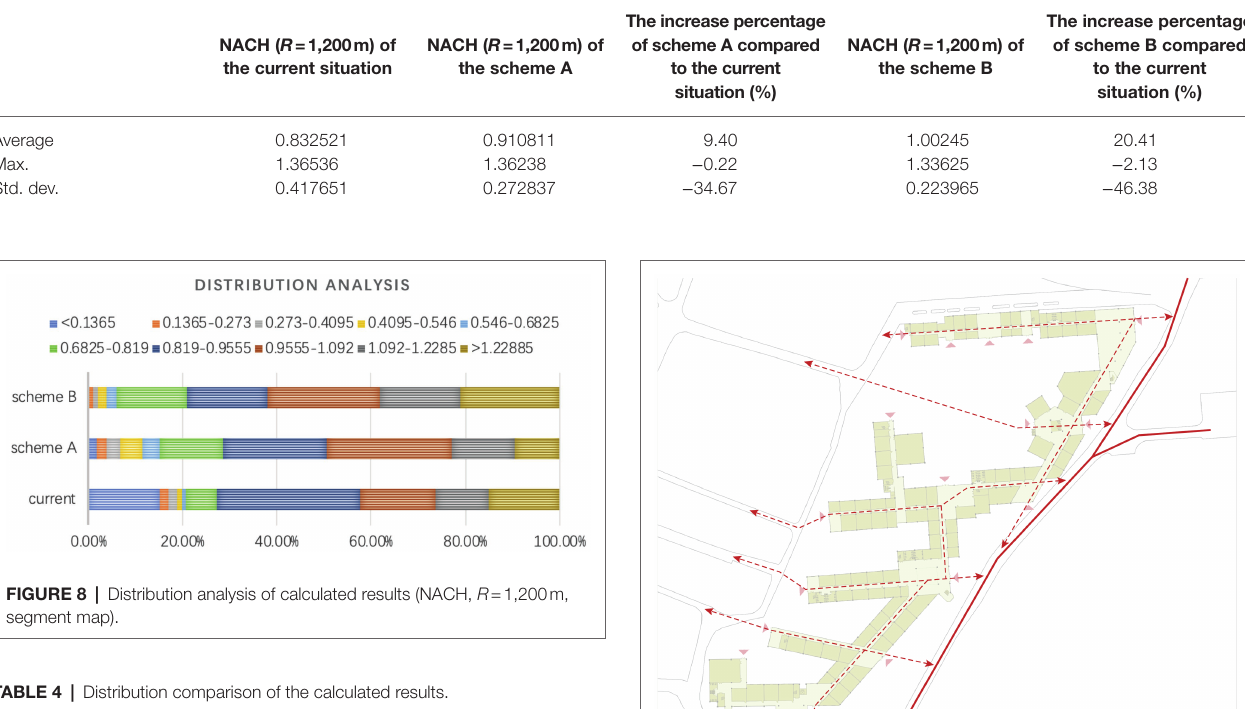
Percentage of segments amount of scheme B (%)